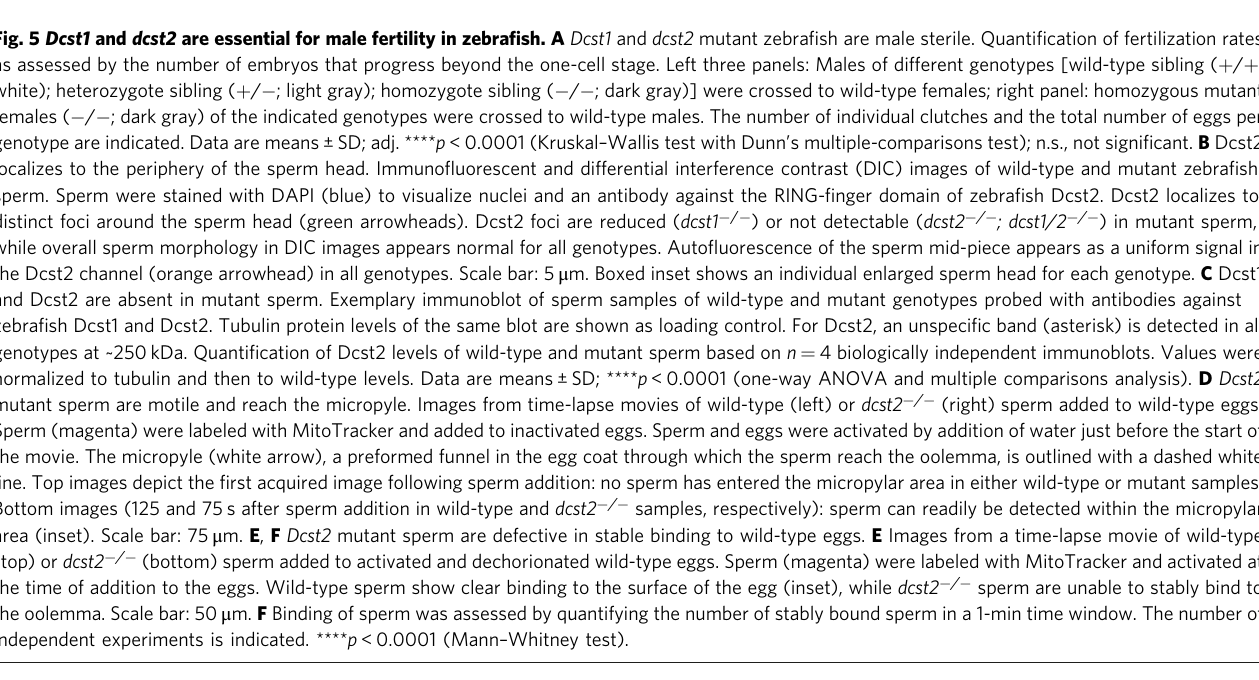
Fig. 5 Dcst1 and dcst2 are essential for male fertility in zebra fi sh. A Dcst1 and dcst2 mutant zebra fi sh are male sterile. Quanti fi cation of fertilization rates as assessed by the number of embryos that progress beyond the one-cell stage. Left three panels: Males of different genotypes [wild-type sibling ( + / + ; white); heterozygote sibling ( + / − ; light gray); homozygote sibling ( − / − ; dark gray)] were crossed to wild-type females; right panel: homozygous mutant females ( − / − ; dark gray) of the indicated genotypes were crossed to wild-type males. The number of individual clutches and the total number of eggs per genotype are indicated. Data are means ± SD; adj. **** p < 0.0001 (Kruskal – Wallis test with Dunn ’ s multiple-comparisons test); n.s., not signi fi cant. B Dcst2 localizes to the periphery of the sperm head. Immuno fl uorescent and differential interference contrast (DIC) images of wild-type and mutant zebra fi sh sperm. Sperm were stained with DAPI (blue) to visualize nuclei and an antibody against the RING- fi nger domain of zebra fi sh Dcst2. Dcst2 localizes to distinct foci around the sperm head (green arrowheads). Dcst2 foci are reduced ( dcst1 − / − ) or not detectable ( dcst2 − / − ; dcst1/2 − / − ) in mutant sperm, while overall sperm morphology in DIC images appears normal for all genotypes. Auto fl uorescence of the sperm mid-piece appears as a uniform signal in the Dcst2 channel (orange arrowhead) in all genotypes. Scale bar: 5 μ m. Boxed inset shows an individual enlarged sperm head for each genotype. C Dcst1 and Dcst2 are absent in mutant sperm. Exemplary immunoblot of sperm samples of wild-type and mutant genotypes probed with antibodies against zebra fi sh Dcst1 and Dcst2. Tubulin protein levels of the same blot are shown as loading control. For Dcst2, an unspeci fi c band (asterisk) is detected in all genotypes at ~250 kDa. Quanti fi cation of Dcst2 levels of wild-type and mutant sperm based on n = 4 biologically independent immunoblots. Values were normalized to tubulin and then to wild-type levels. Data are means ± SD; **** p < 0.0001 (one-way ANOVA and multiple comparisons analysis). D Dcst2 mutant sperm are motile and reach the micropyle. Images from time-lapse movies of wild-type (left) or dcst2 − / − (right) sperm added to wild-type eggs. Sperm (magenta) were labeled with MitoTracker and added to inactivated eggs. Sperm and eggs were activated by addition of water just before the start of the movie. The micropyle (white arrow), a preformed funnel in the egg coat through which the sperm reach the oolemma, is outlined with a dashed white line. Top images depict the fi rst acquired image following sperm addition: no sperm has entered the micropylar area in either wild-type or mutant samples. Bottom images (125 and 75 s after sperm addition in wild-type and dcst2 − / − samples, respectively): sperm can readily be detected within the micropylar area (inset). Scale bar: 75 μ m. E , F Dcst2 mutant sperm are defective in stable binding to wild-type eggs. E Images from a time-lapse movie of wild-type (top) or dcst2 − / − (bottom) sperm added to activated and dechorionated wild-type eggs. Sperm (magenta) were labeled with MitoTracker and activated at the time of addition to the eggs. Wild-type sperm show clear binding to the surface of the egg (inset), while dcst2 − / − sperm are unable to stably bind to the oolemma. Scale bar: 50 μ m. F Binding of sperm was assessed by quantifying the number of stably bound sperm in a 1-min time window. The number of independent experiments is indicated. **** p < 0.0001 (Mann – Whitney